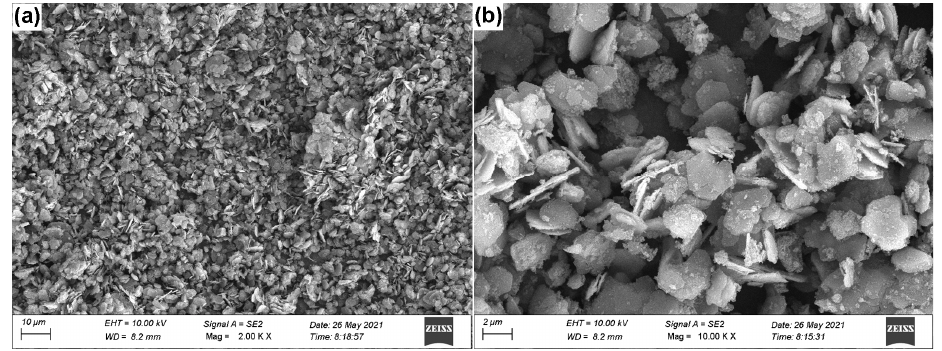
Figure 2. SEM images of: ( a ) the synthesized CaAl LDH − NO 3 − ; ( b ) the enlarged SEM images of ( a ).